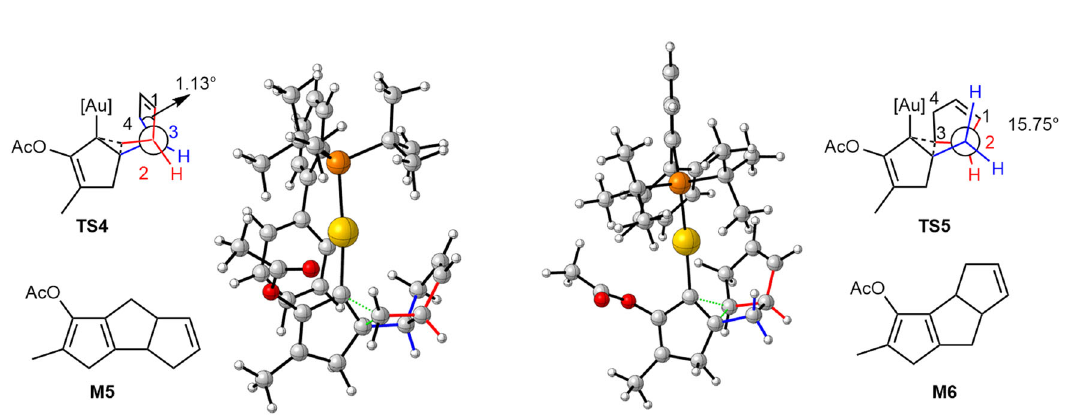
Fig. 8 | The Newman projected structure of the transition states TS4 and TS5. The torsion angles are computed at the M06-L/def2-TZVPP/SMD dichloroethane //M06-L/ def2-SVP/SMD dichloroethane